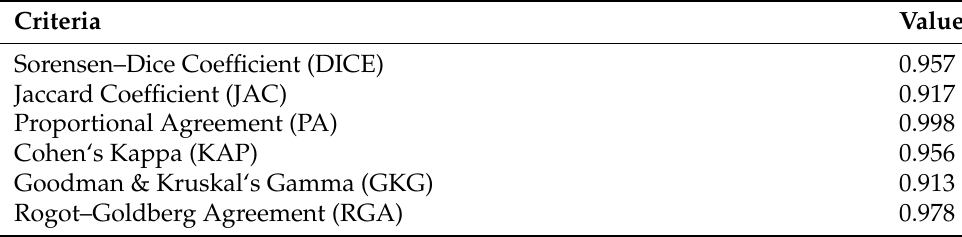
Figure 5. CT image of the patient ( A ); CT image of the 3D-printed phantom located on the surface of CT head phantom ( B ); overlapping of patient’s and of 3D-printed phantom’s CT images obtained using open access software DSCImageCalc ( C ). Table 2. Similarity coefficients calculated using the DSCImageCalc